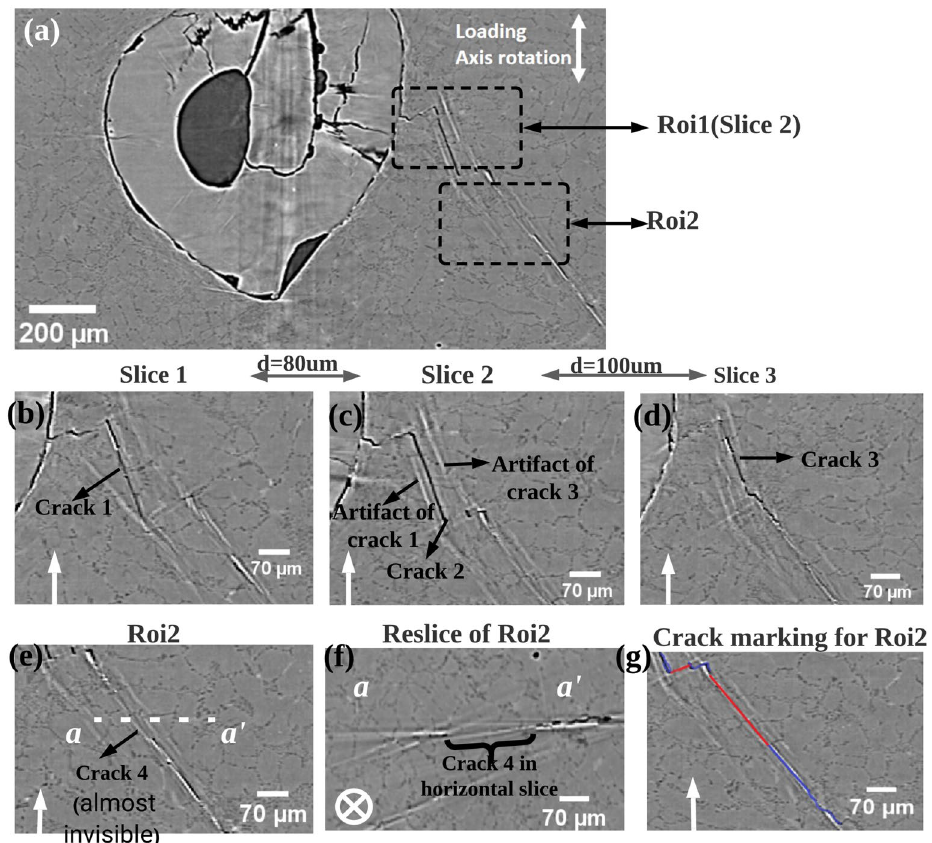
Figure 13. Analysis of cracks and artifacts in vertical slices of experimental scans: experimental SRCT images of cracked AlSi7 specimens which have been obtained at SLS TOMCAT beamline. The scans conditions are completely identical as Fig. 2. ( a ) A 2D experimental vertical slice, two ROIs were analyzed, in ROI1 the cracks appear dark and in ROI2 the cracks are invisible; ( b – d ) Enlarged view of ROI1: ( c ), the slice in front of ( c ) at a distance of 80 µ m: ( b ) and behind it at a distance of 100 µ m: ( d ); ( e ) Enlarged view of ROI2; ( f ) Horizontal re-slice of white dashed line (a–a ′ ) which shows that there is invisible crack (named crack4); ( g ) Crack marking for Roi2: markings in blue indicate a crack containing dark voxels and in red indicate an invisible crack whose presence needs to be confirmed by artifacts in horizontal